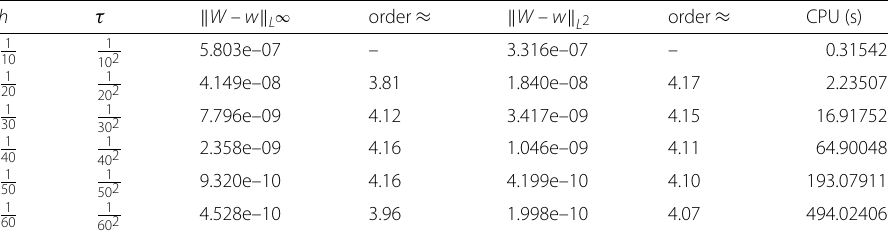
Table 5 Errors and computational orders of compact difference scheme with β = 10 for W